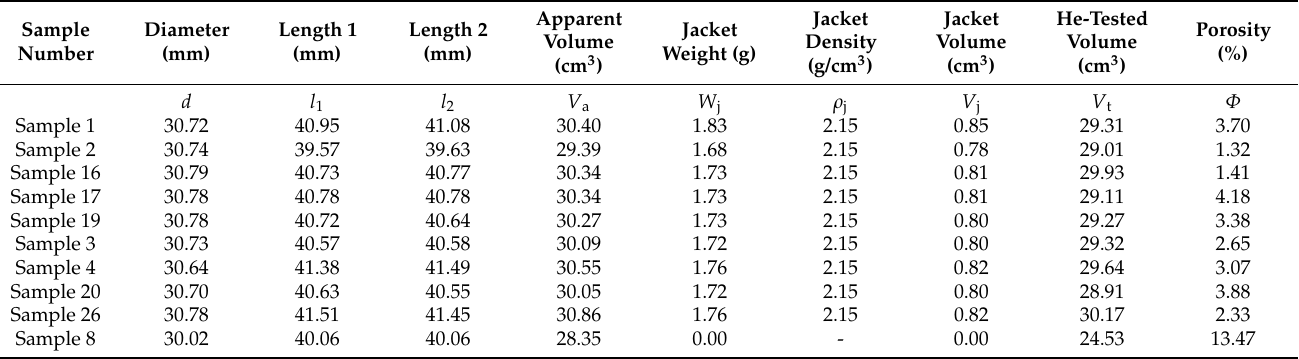
Table 1. Summary of the measured sample